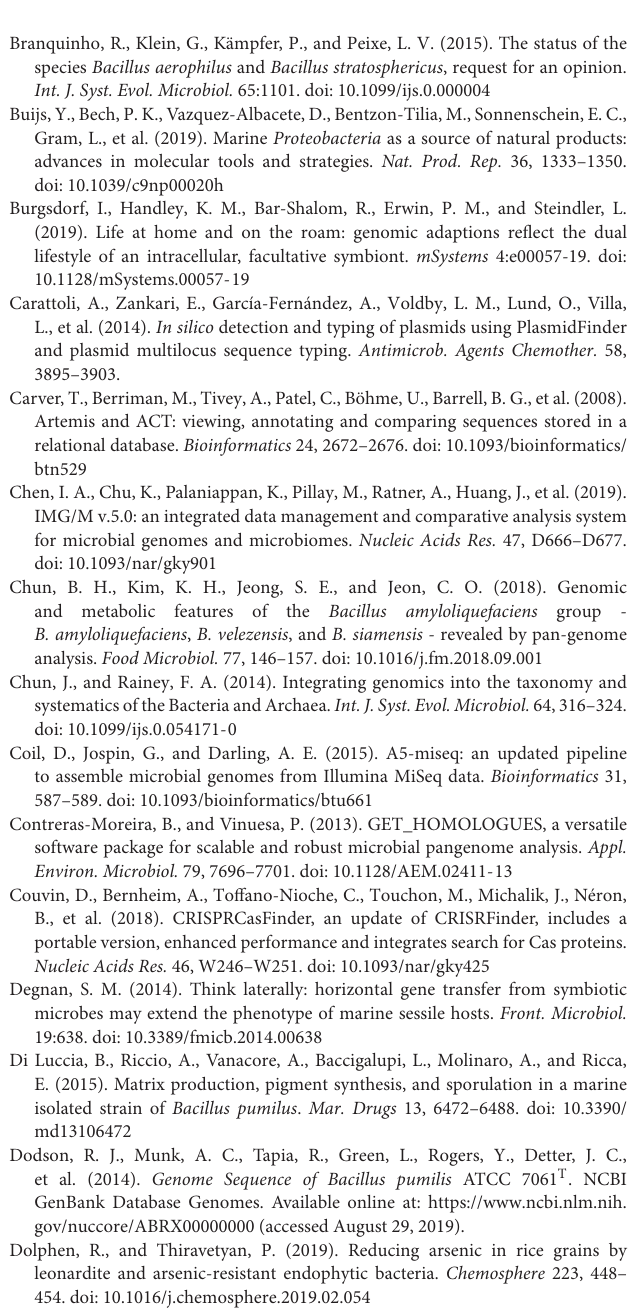
Supplementary Figure 6 | Type III-B CRISPR-Cas10 system identified in the B. pumilus 64-1 genome: (A) genomic organization adapted by the CRISPRCasFinder program and Artemis. Highlighted in brown the spacer sequence showing similarity with the B. safensis KCTC 12796BP genome; (B) RNA structure (colored by base-pairing probability) predicted by RNAFolder web server. Supplementary Table 1 | Genome properties of B. pumilus 64-1.